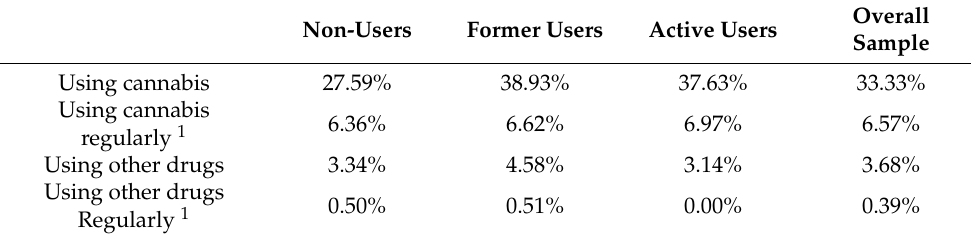
Table 2. Percentage of participants who declared using illicit